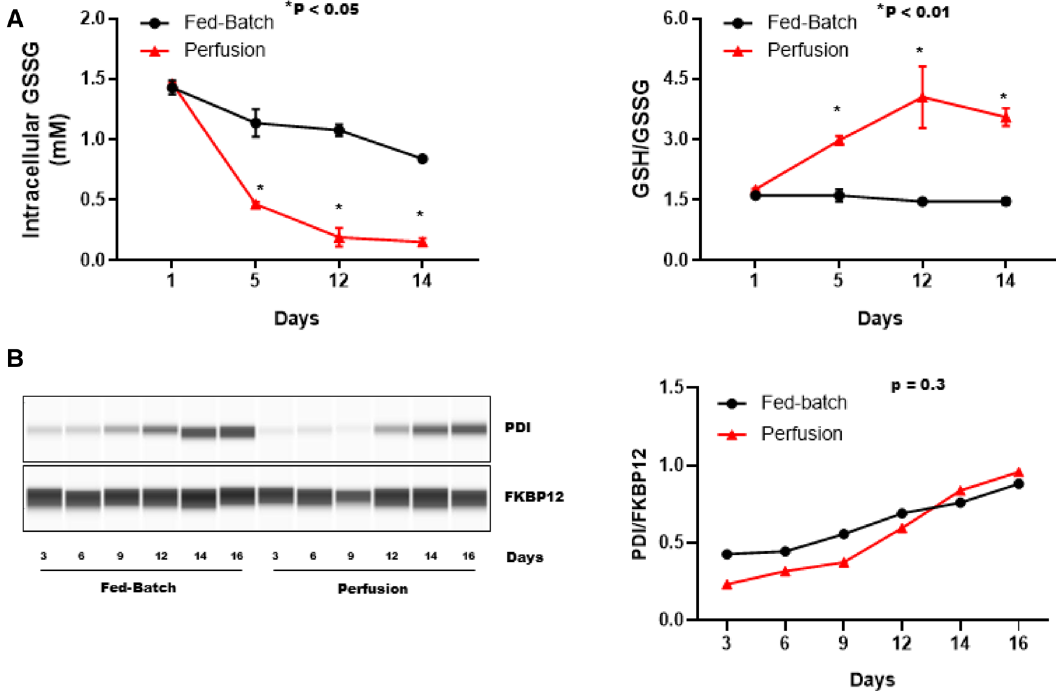
Figure 5. Analysis of the intracellular redox-state. ( A ) Cell samples were taken on the indicated days from each bioreactor and intracellular redox state was determined by measuring relative changes in intracellular glutathione concentration. Intracellular concentration of oxidized glutathione (GSSG) in fed-batch and perfusion bioreactors is shown in the left panel. Ratio of reduced glutathione (GSH) to GSSG is shown in the right panel. A higher ratio of GSH/GSSG is indicative of reduced intracellular redox-state. All data are expressed as mean ± SD. ( B ) Cell pellets were collected on the indicated days from a fed-batch and a perfusion bioreactor to determine changes in protein disulfide isomerase (PDI) (~ 57 kDa). Representative western blot image is shown in the left panel. Data is expressed as PDI AUC/FKBP12 AUC in the right